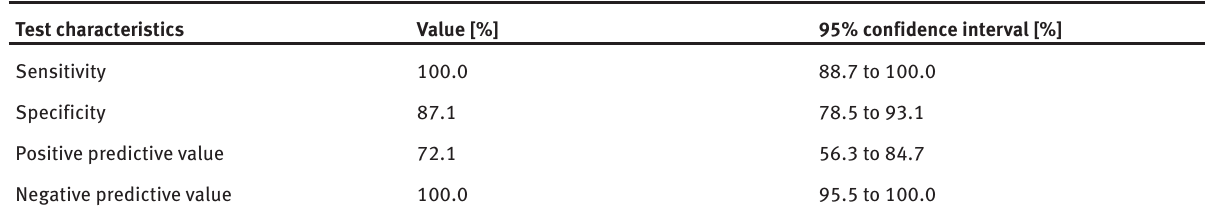
Table 3: Diagnostic test evaluation of CE-US using CE-MRA as basis for the calculations. Test characteristics